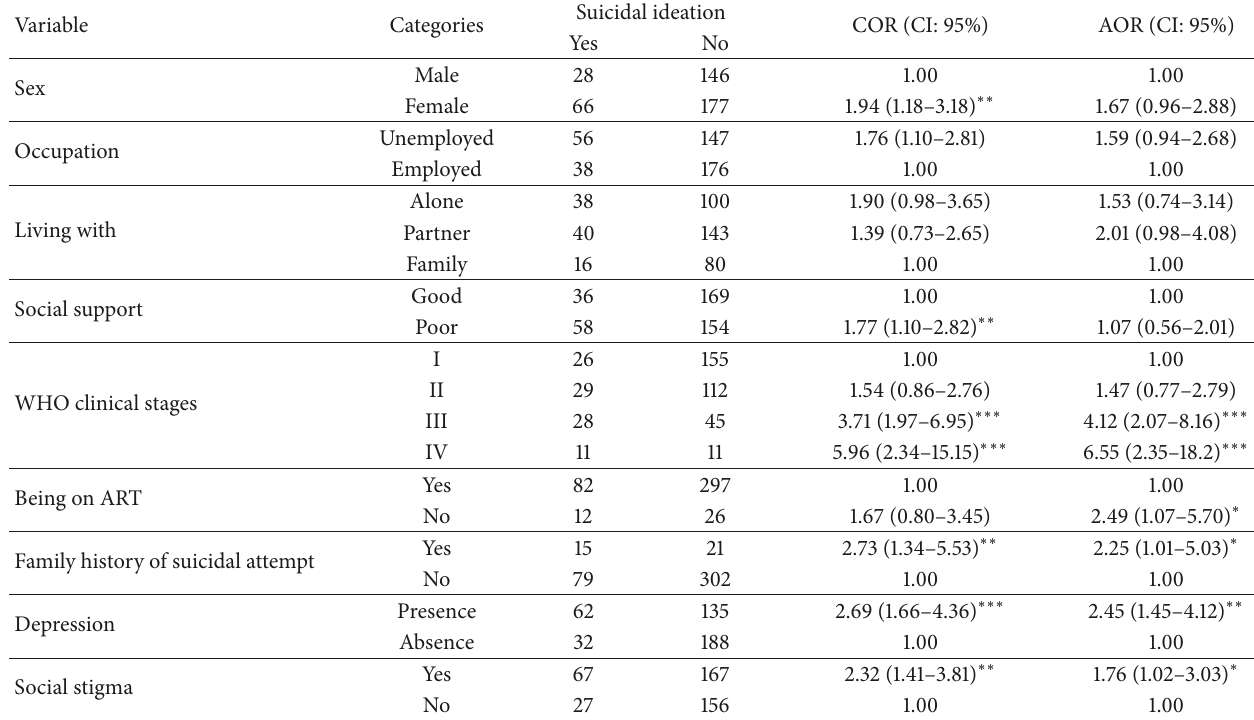
Table 2: Logistic regression analysis of factors associated with suicidal ideation among HIV-positive people at Zewditu Memorial Hospital, Addis Ababa, Ethiopia, June 2014.